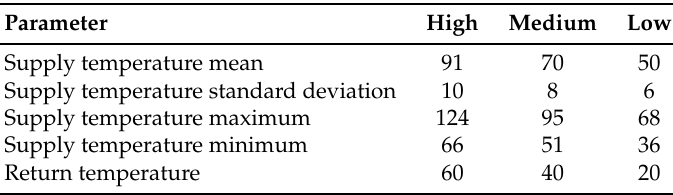
Table 1. Case study temperature levels in ◦ C.